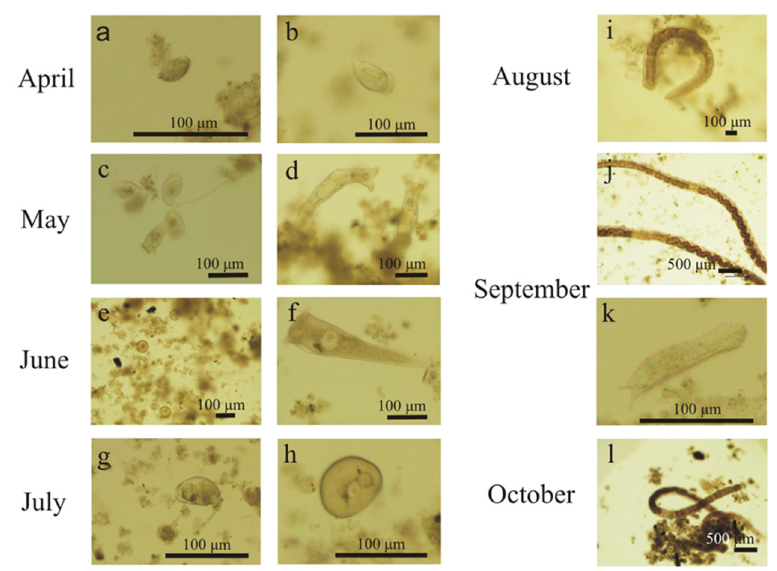
Figure 5. Examples of characteristic microorganisms observed on the fibers during 184 days of operation from April to October 2021 figures ( a – l ) are referred to in thet ext).